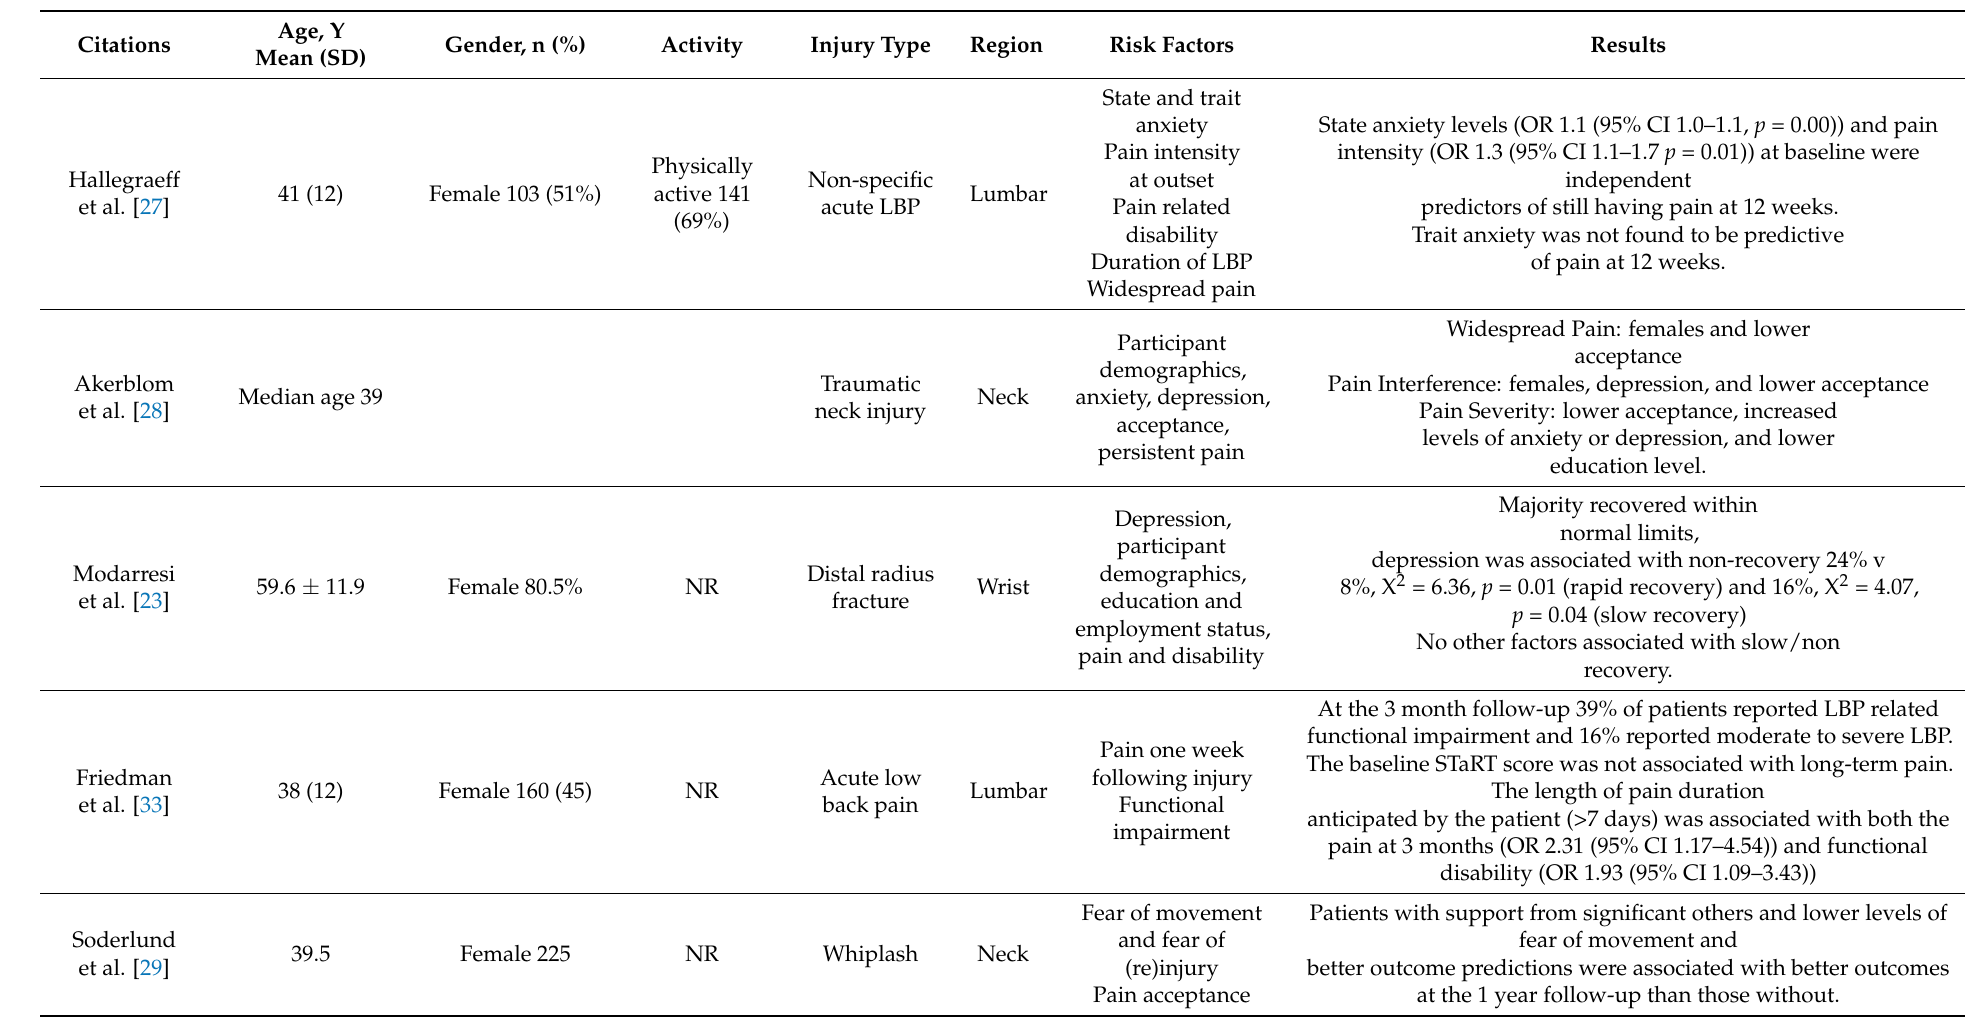
Table 3. Risk factors for causing persistent pain following musculoskeletal